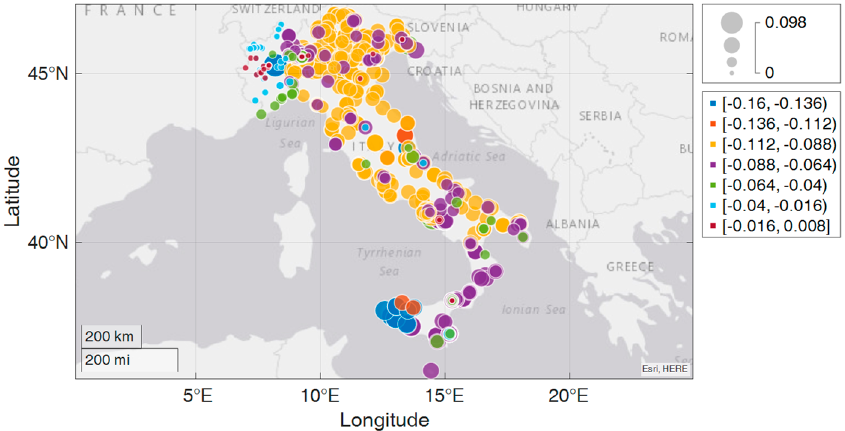
Figure 5. The colour and the size of the bubbles represent the mean value and the variance of the PTDF for a node, respectively.